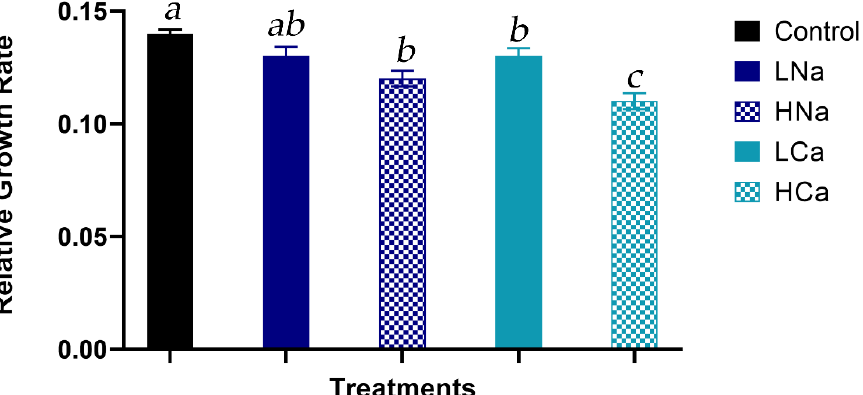
Figure 2. Relative Growth Rate (RGR) in Valerianella locusta plants grown in a floating system, as influenced by four salinity treatments (referred to as low and high salinity level) and the salinity source. Control: standard nutrient solution (−0.08 MPa, 20 °C); LNa: low NaCl-salinity (−0.18 MPa, 20 °C); HNa: high NaCl-salinity (−0.28 MPa, 20 °C); LCa: low CaCl 2 -salinity (−0.018 MPa, 20 °C); HCa: high CaCl 2 -salinity (−0.28 MPa, 20 °C). Vertical bars indicate ± standard errors of means of three measurements. Same letters indicate non-significant differences at p ≤ 0.05 according to Duncan’s multiple range test.